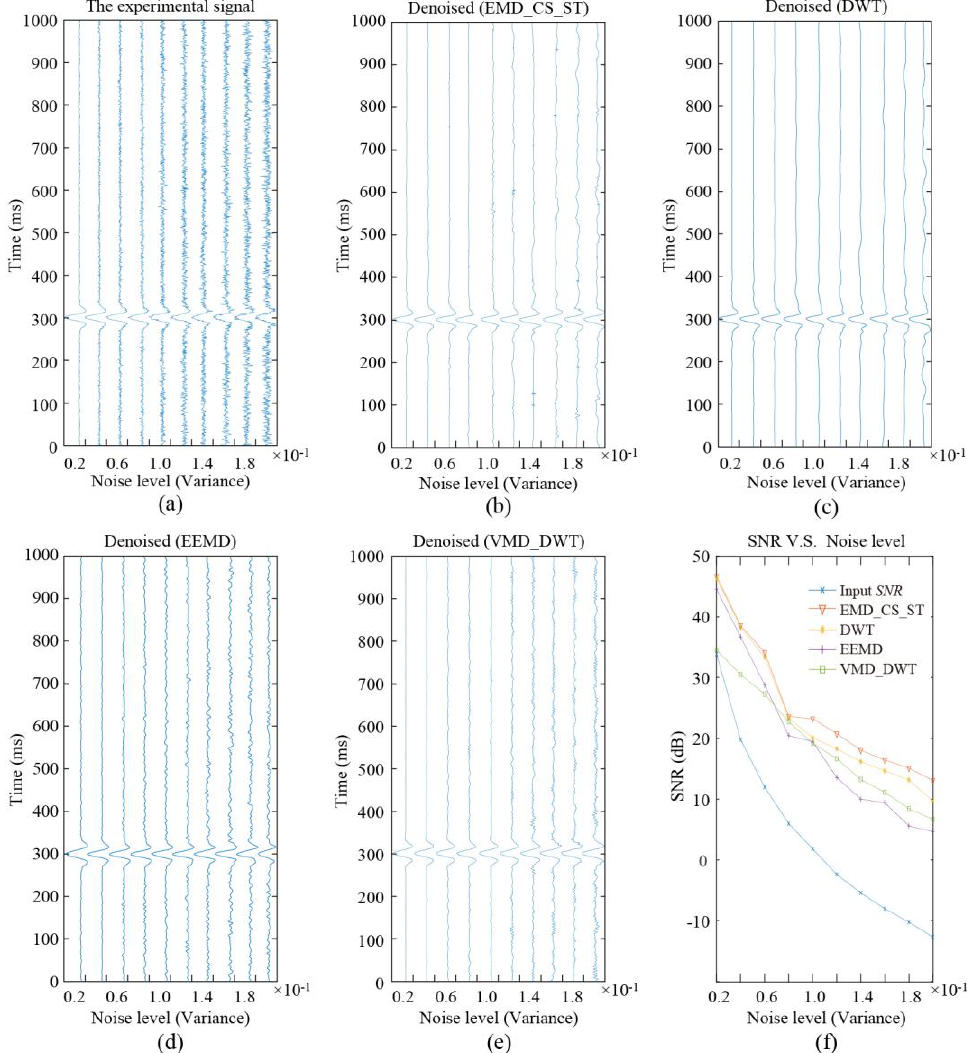
Figure 9. The comparative experiments under different noise levels. ( a ) The original signal. ( b ) The EMD_CS_ST denoised signal. ( c ) The DWT denoised signal. ( d ) The EEMD denoised signal. ( e ) The VMD_DWT denoised signal. ( f ) The SNR before and after denoising.